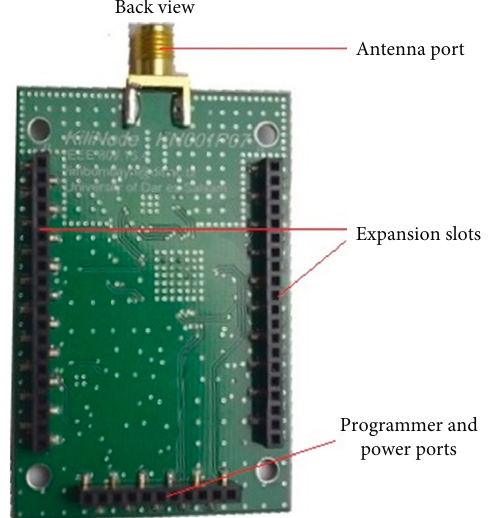
Figure 2: KiliNode back view showing the hardware interfacing, programming, and power interfacing